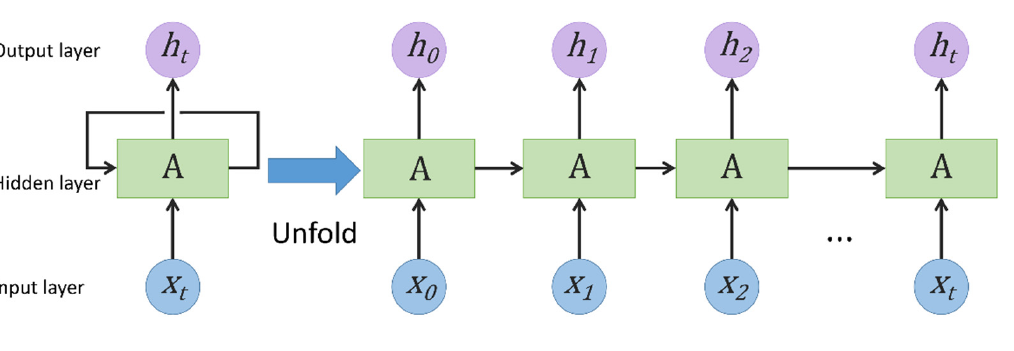
Figure 1. Structure of Recurrent neural network. h t and x t represent the output and input at time t , respectively .